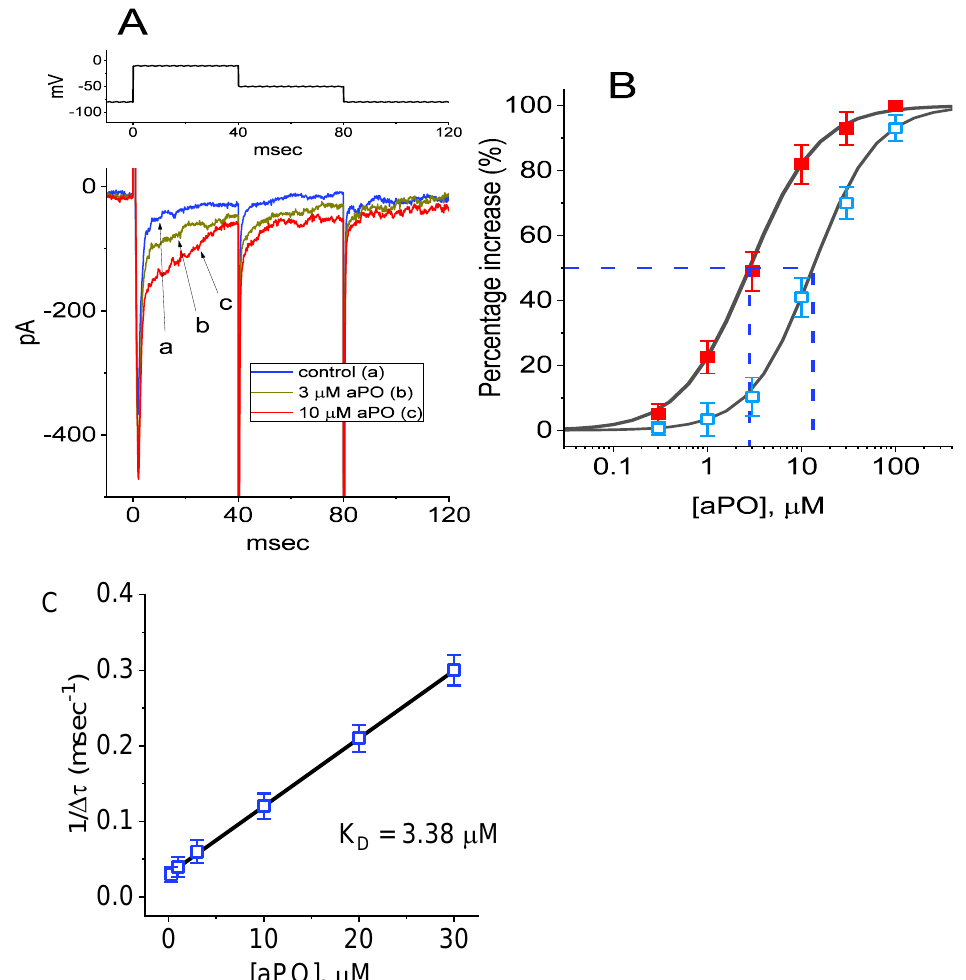
Figure 1. Effect of aPO on the peak and late components of voltage-gated Na + current (I Na ) identified in pituitary GH 3 cells. These experiments were undertaken in cells bathed in Ca 2+ -free Tyrode’s solution containing 10 mM tetraethylammonium chloride (TEA), whereas the recording pipette was filled up with Cs + -enriched solution. ( A ) Representative I Na traces activated by brief depolarizing pulse (indicated in the upper part). a: control (i.e., aPO was not present); b: 3 µ M aPO ; c: 10 µ M aPO . ( B ) Concentration-dependent stimulation of aPO on peak or late I Na (mean ± SEM; n = 8 for each point). The peak ( (cid:3) ) or late ( (cid:4) ) amplitude of the current was measured at the beginning or end of a 40-ms depolarizing pulse from − 80 to − 10 mV. Data analysis was performed by ANOVA-1 ( p < 0.05). Each continuous line illustrates the goodness-of-fit to the Hill equation, as elaborated in Materials and Methods. The vertical broken line indicates the EC 50 value required for 50% stimulation of the current (peak or late I Na ). ( C ) The relationship of the reciprocal to the time constant (i.e., 1/ ∆ τ ) versus the aPO concentration was plotted (mean ± SEM; n = 7–11 for each point). From the binding scheme (indicated under Materials and Methods), the forward ( k +1 *) or backward ( k − 1 ) rate constant for aPO -accentuated I Na in GH 3 cells was computed to be 0.00898 ms − 1 µ M − 1 or 0.0303 ms − 1 ,